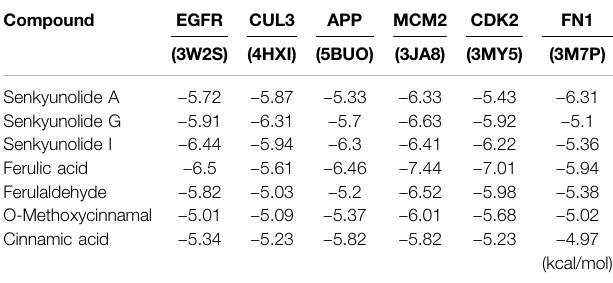
TABLE 5| Resultsofmolecular docking studiesofsevencompounds intheactive sites of six proteins performed using Autodock 4.2.